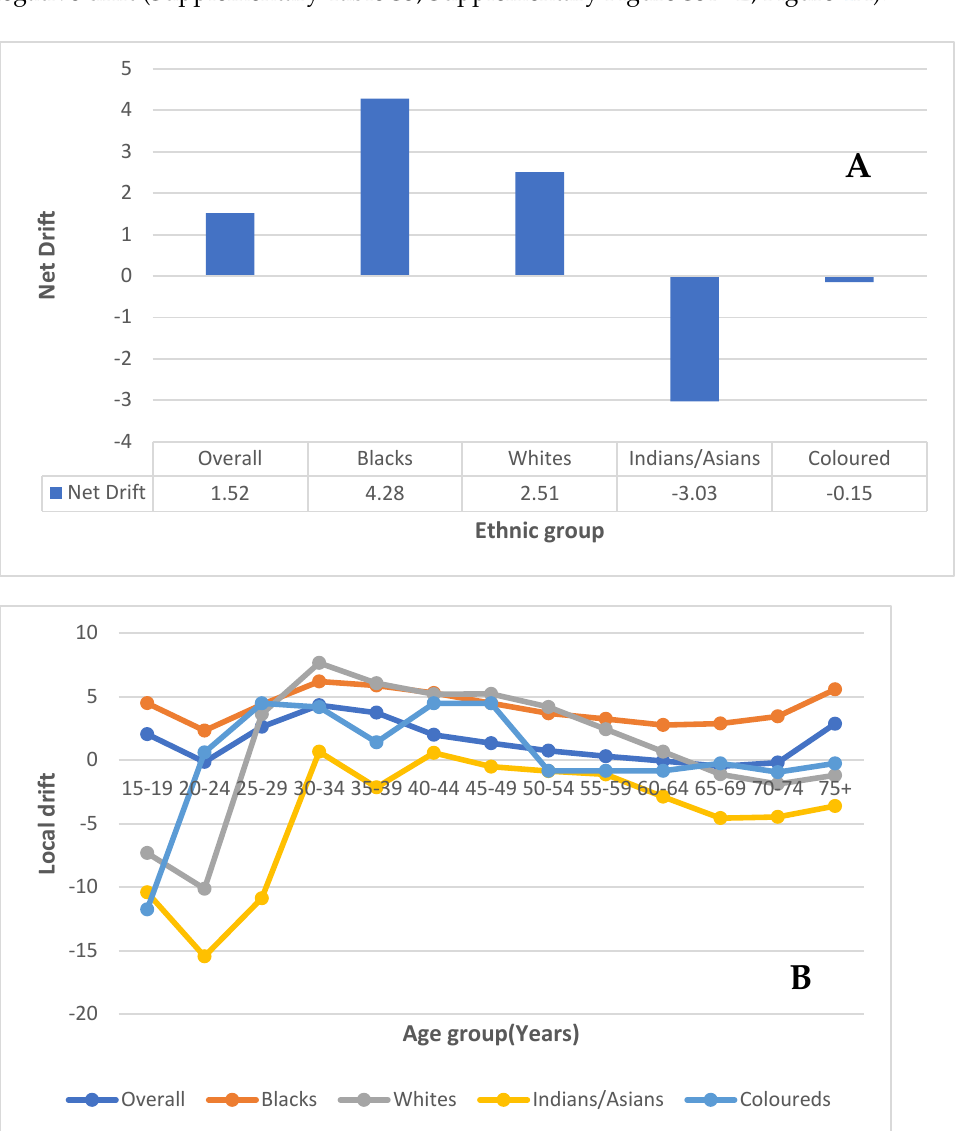
Figure 4. Net ( A ) and local drift ( B ) of cervical cancer mortality in South Africa (1999–2018). (National and ethnic trends)